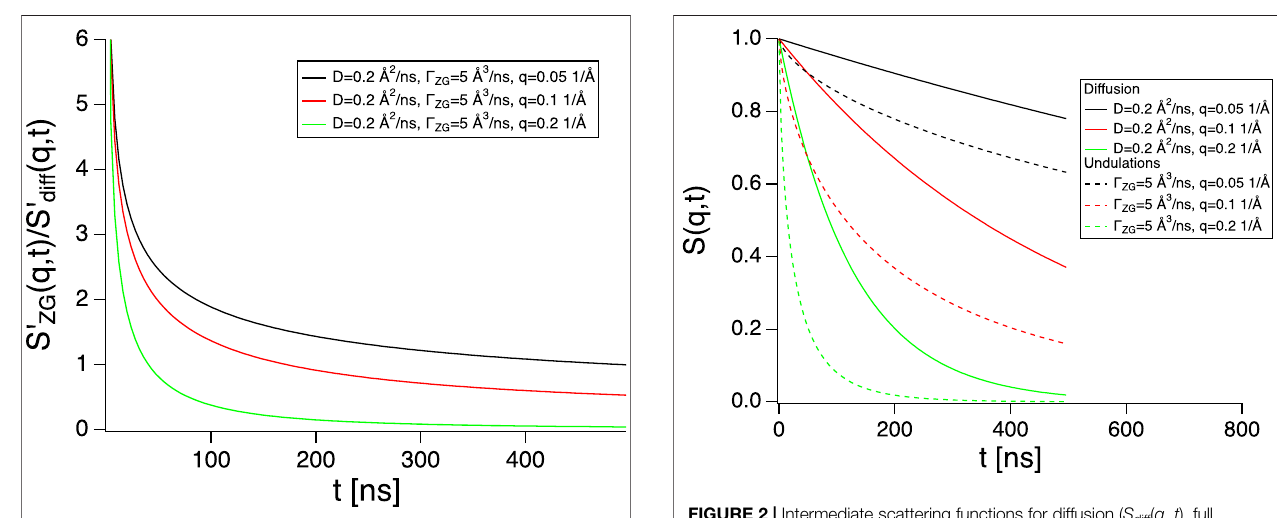
FIGURE 1 | Ratio between the slope of the Zilman-Granek stretched exponential (see Eq. 6 ) and the derivative of simple exponential for diffusion with parameters typical for fl uid phase lipid vesicles. Only at short times the contribution from diffusion is negligible.